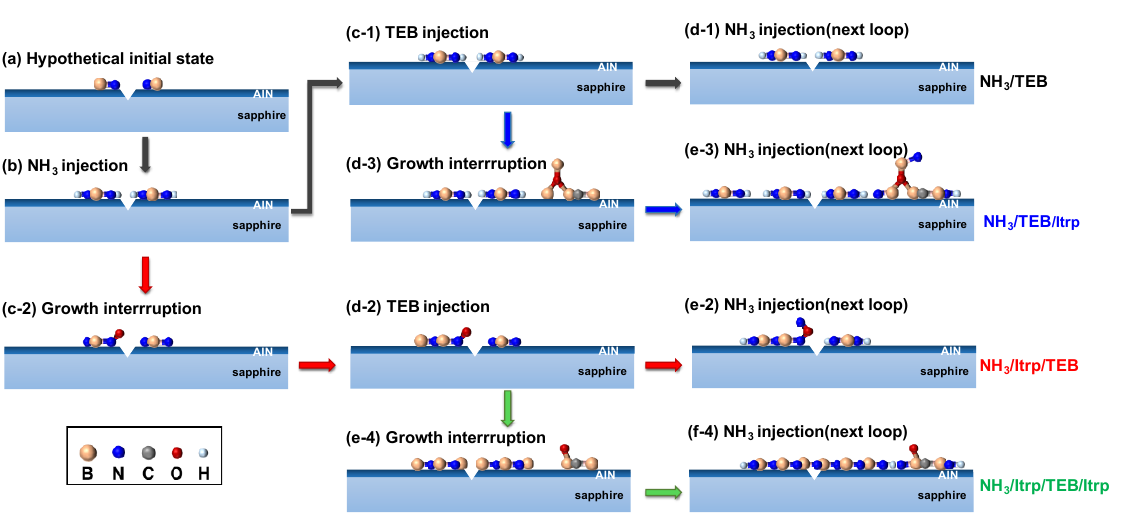
Figure 7. Schematic growth model of h-BN grown by NH 3 /TEB ( a , b , c-1 , d-1 ), NH 3 /Itrp/TEB ( a , b , c-2 , d-2 , e-2 ), NH 3 /Itrp/TEB ( a , b , c-1 , d-3 , e-3 ) and NH 3 /Itrp/TEB/Itrp ( a , b , c-2 , d-2 , e-4 , f-4 ).